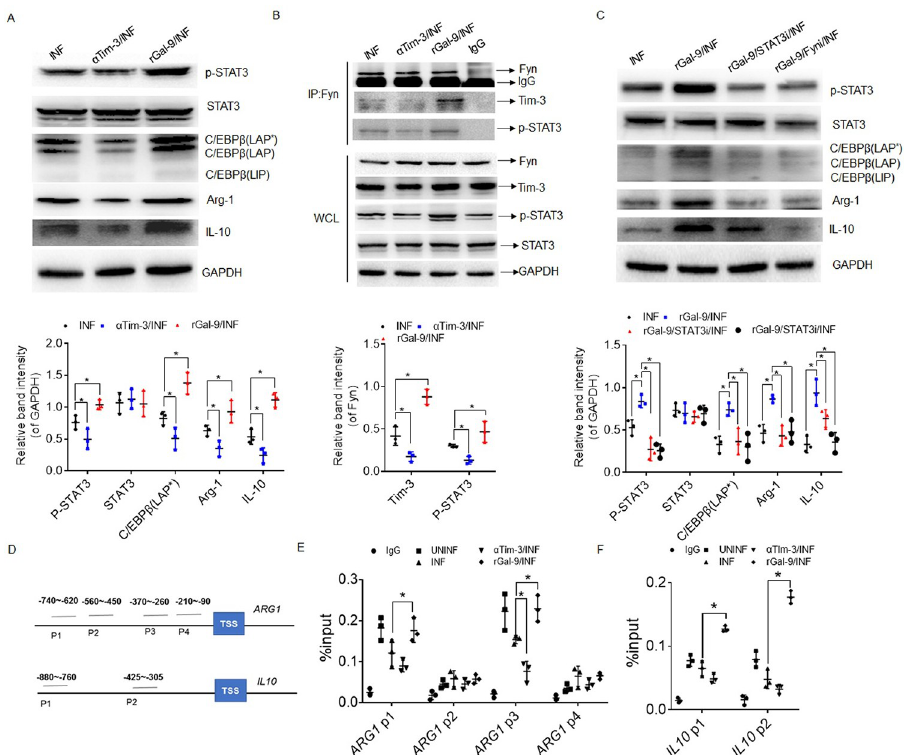
Fig 4. The Tim-3-Fyn-STAT3-C/EBP β pathway mediates Arg-1 and IL-10 expression in MDSCs following T . gondii infection. (A) Western blot analysis and statistical analysis of the expression of STAT3, phosphorylated (p)- STAT3, C/EBP β , Arg-1, and IL-10 in MDSCs treated with α Tim-3 or artificial recombinant galectin-9 (rGal-9) during T . gondii infection. The quantified relative band intensity was determined by ImageJ (similarly hereinafter). The results are shown as the mean ± SD of three separate experiments, One-way ANOVA, * p < 0.05. (B) Coimmunoprecipitation (Co-IP) analysis of the interaction between Fyn and Tim-3 and between Fyn and p-STAT3 in the MDSCs treated with α Tim-3 or rGal-9 during T . gondii infection. The results are shown as the mean ± SD of three separate experiments, One-way ANOVA, * p < 0.05. (C) Western blot analysis and statistical analysis of the expression of STAT3, p-STAT3, C/EBP β , Arg-1, and IL-10 in the MDSCs treated with an inhibitor of STAT3 or Fyn in the presence of rGal-9 during T . gondii infection. The results are shown as the mean ± SD of three separate experiments, One-way ANOVA, * p < 0.05. (D) Schematic diagram shows the possible binding site of C/EBP β on the promoter regions of ARG1 and IL10 . (E–F) ChIP-PCR of C/EBP β binding regions on the promoter of € G1 (E) and IL10 (F). ChIP assays were performed using anti-C/EBP β antibody and then qRT–PCR. The data in all panels are representative of at least three independent experiments. The data are presented as the mean ± SD, * p < 0.05, One-way ANOVA. UNINF, normal control; INF, T . gondii